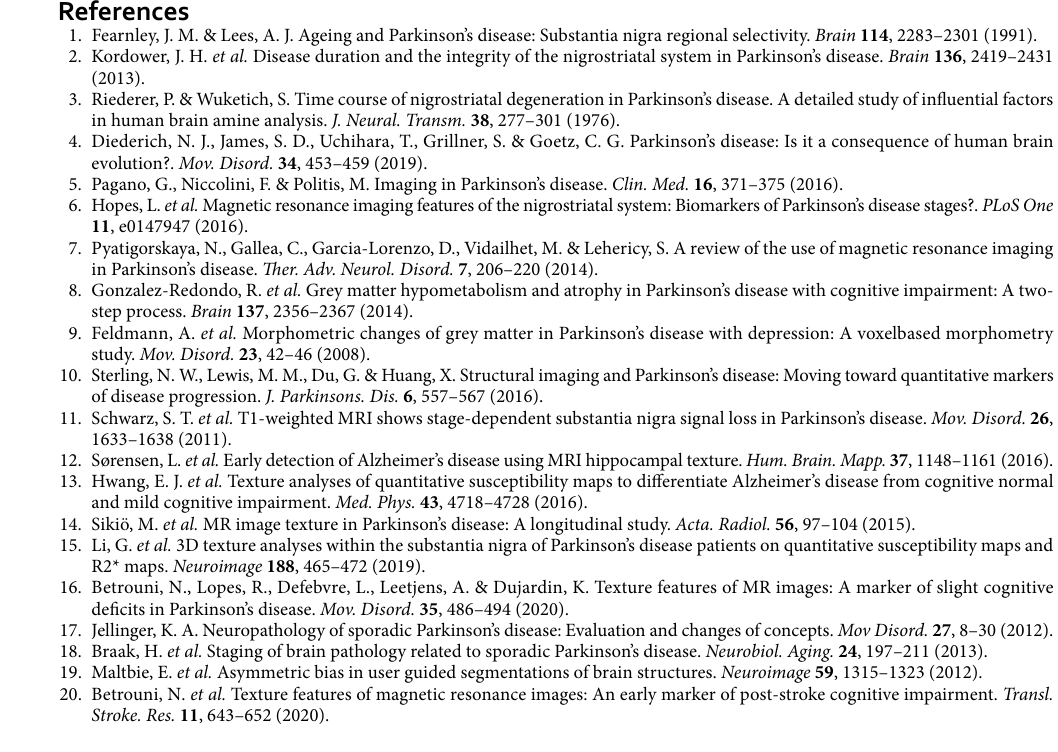
Texture features were computed using in-house software and the XLSTAT software plug-in (AddinSoft, www. xlsta t.com) was used to perform all statistical tests. The code package as well as all the data used in this study are available for download.